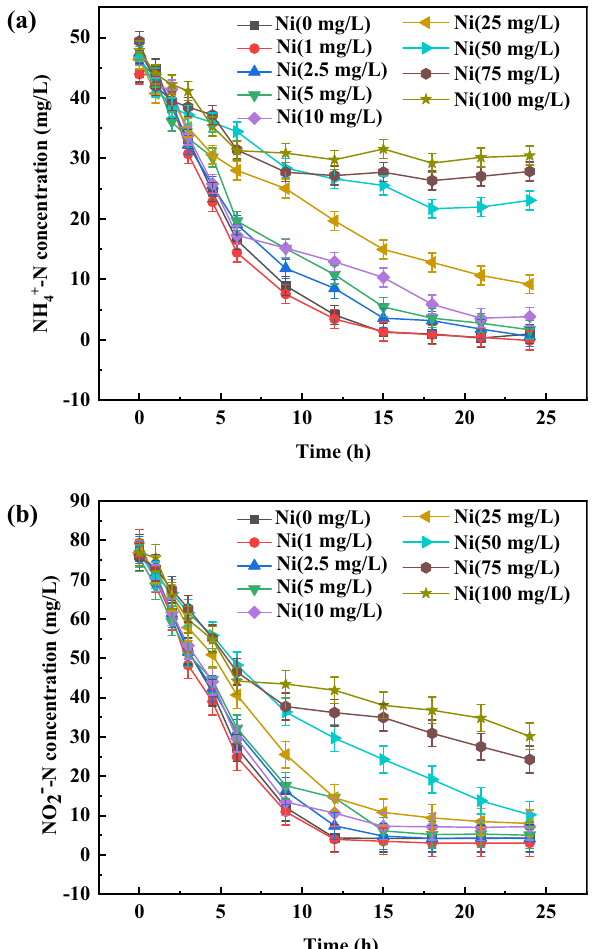
Figure 3. NH 4 + -N ( a ) and NO 2 − -N ( b ) concentration change with time under different Ni(II)